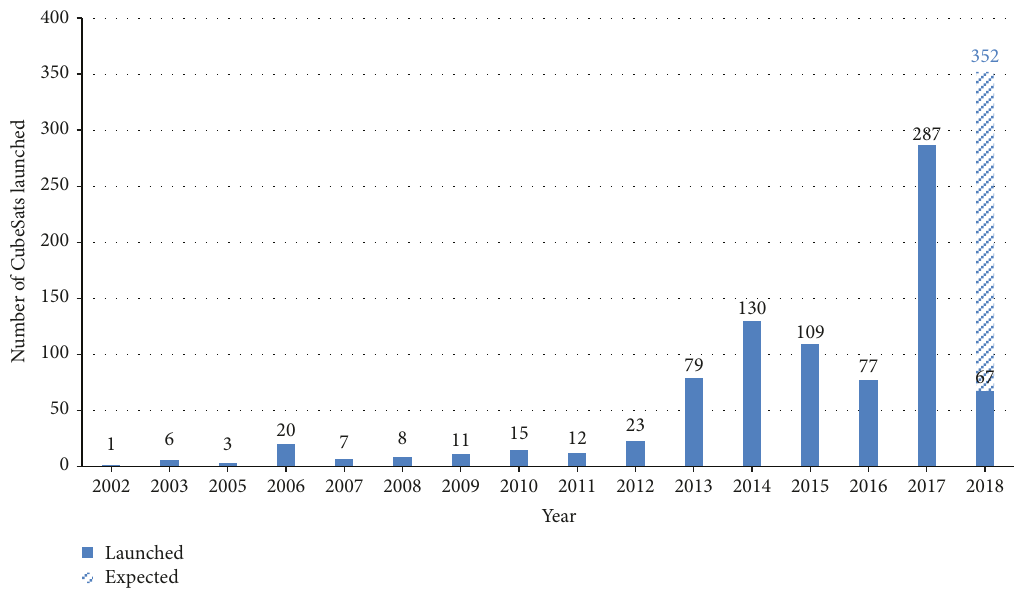
Figure 1: Number of CubeSats launched per year from 2002 to May 31, 2018, totaling 855